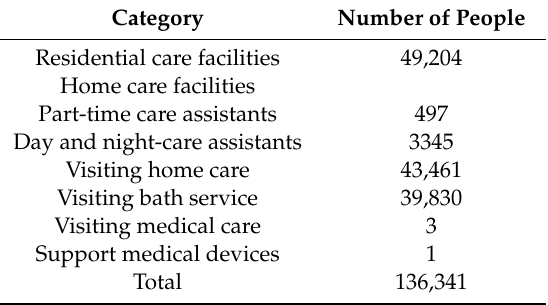
Figure 1. Wage distribution of workers in residential care and home care facilities. ( a ) Distribution of residential care facilities (monthly wage); ( b ) distribution of home care facilities (hourly wage). Table 1. Sta ff of residential care and home care